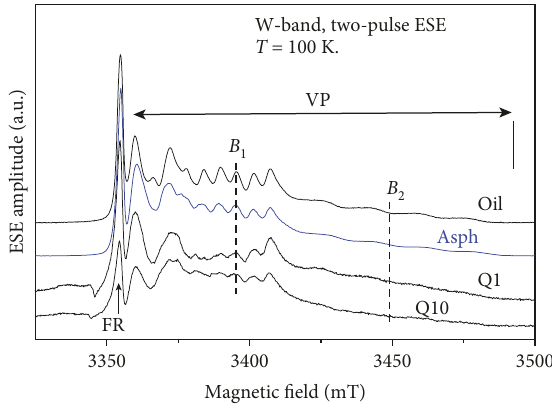
= 3395 3mT and (b) 1